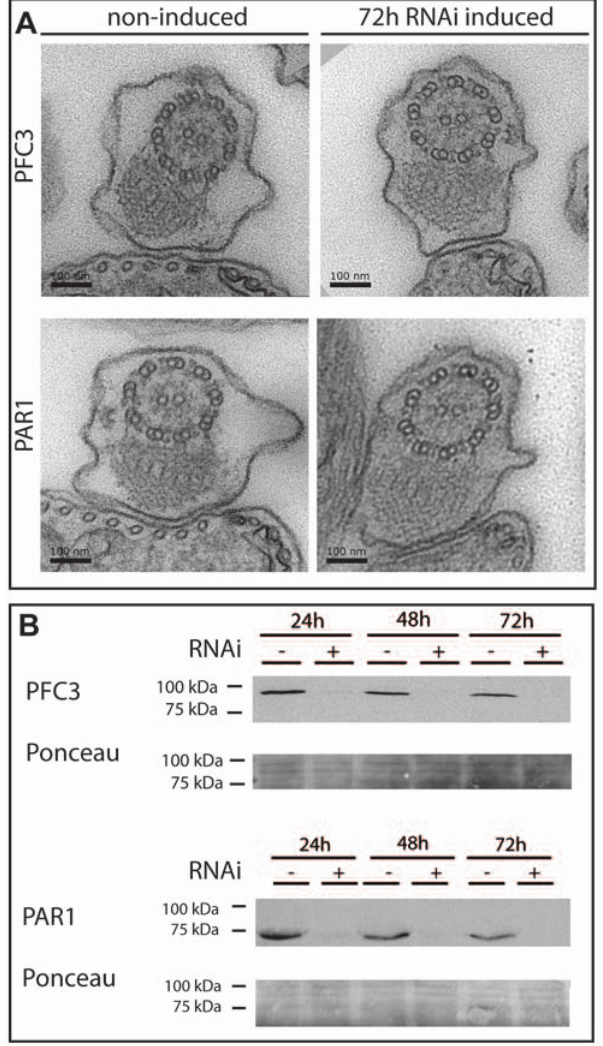
Figure 6. Analysis of PFC3 and PAR1 after induction of RNAi. A. Thin-section electron microscopy of whole cells reveals no detectable structural change in the PFR organisation after RNAi ablation of either PFC3 or PAR1. B. Western blotting analysis shows ablation of both PFC3 and PAR1 protein levels by 24 hours after induction of RNAi. Ty epitope tagged PFR proteins were detected using BB2 antibody. Ponceau stained membranes show loading of protein samples.